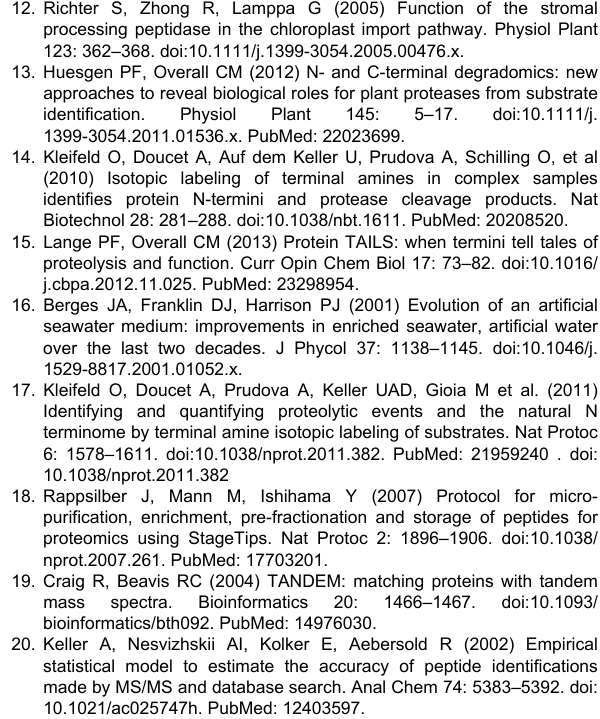
Table S7. List of 63 plastid transit peptides derived from identified mature N termini of nuclear-encoded,